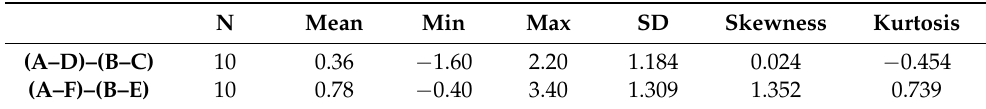
Table 4. Basic statistics of the difference in bilateral measurements of the maxillary alveolar process— control group.